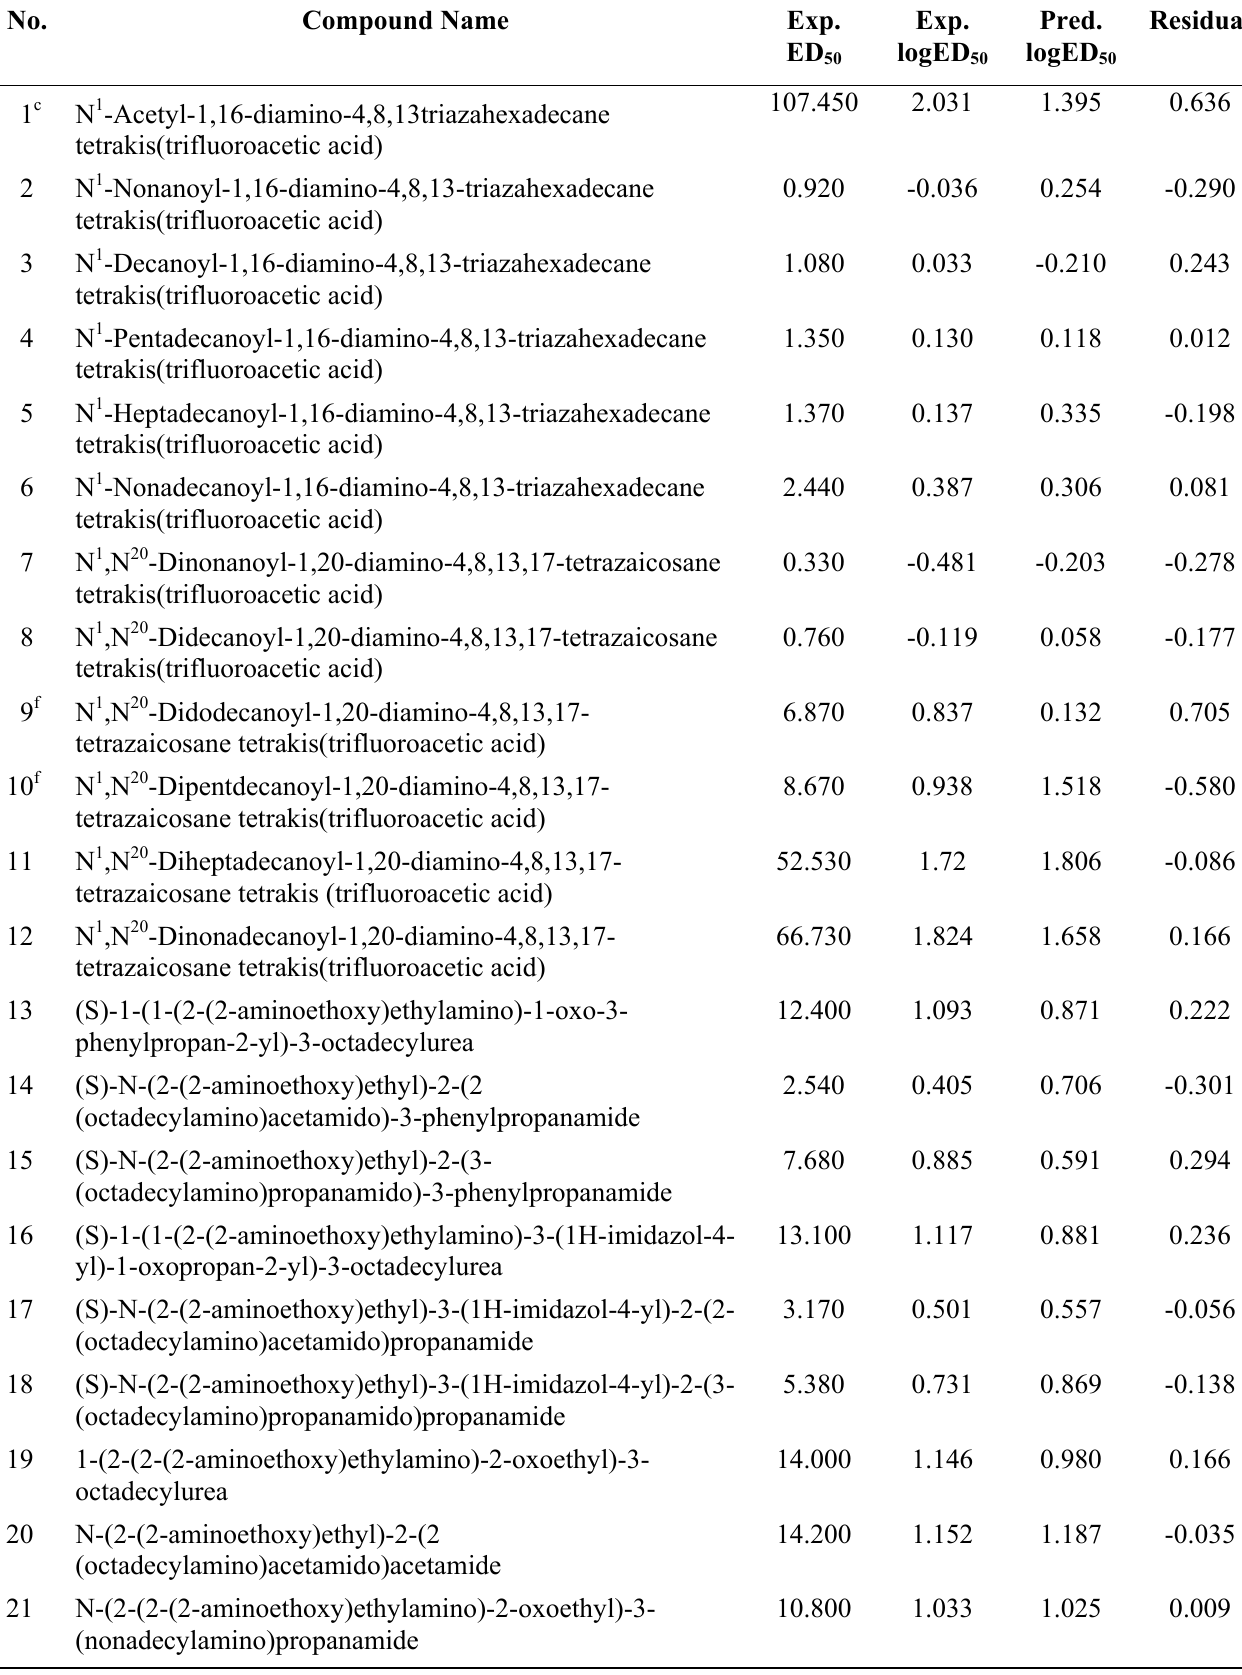
Table 2. Data set of the anti-endotoxins a